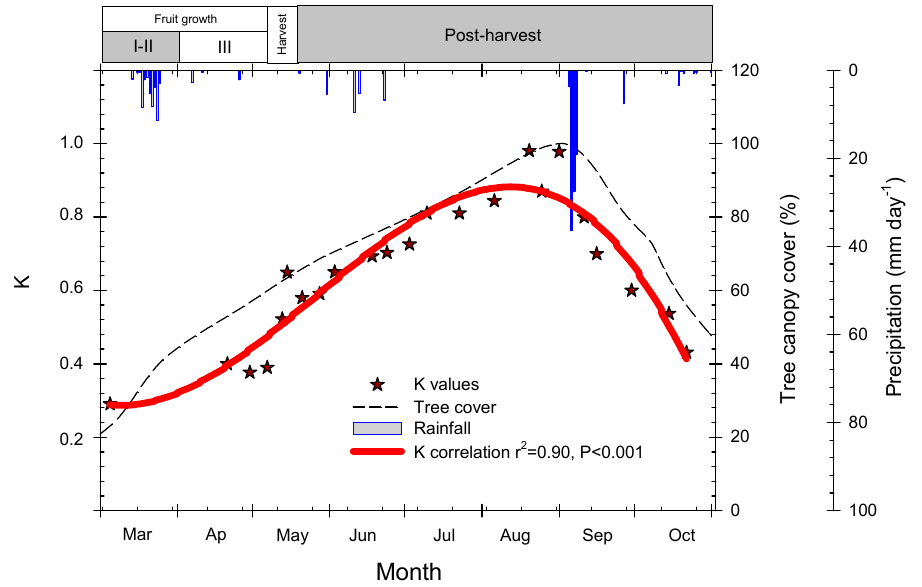
Figure 4. Seasonal evolution of irrigation factor (IF, ), canopy tree cover (%, dashed line) for early-maturing nectarine trees, and daily precipitation (mm day − 1 , vertical bars) during the irrigation period. The red line represents the adjusted IF values to a curvilinear regression. Phenological stages for nectarine trees are depicted in the top box.